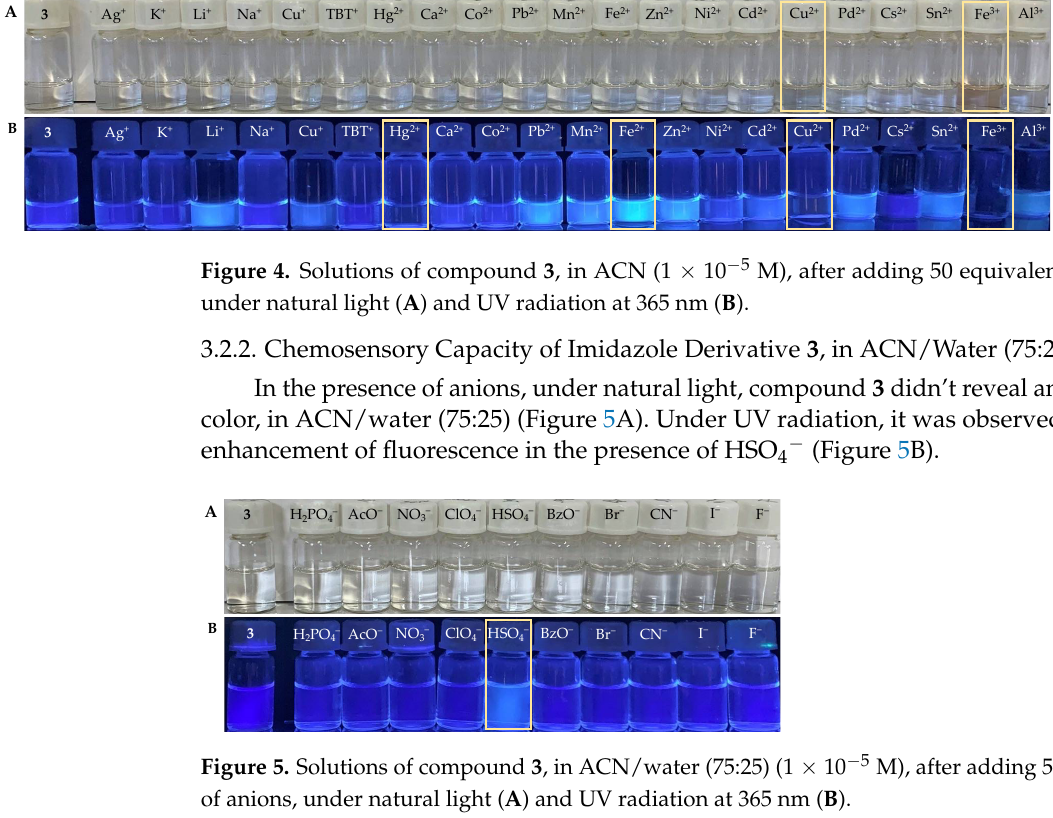
Figure 3. Solutions of compound 3 , in ACN (1 × 10 −5 M), after adding 50 equivalents of anions, under natural light ( A ) and UV radiation at 365 nm ( B ).